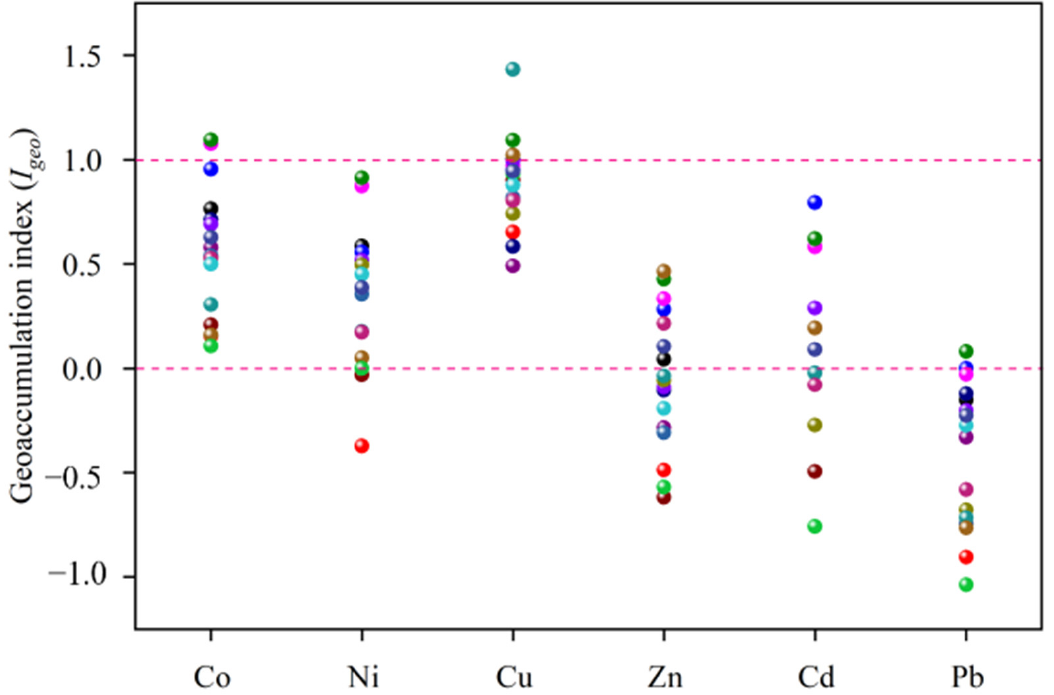
Figure 3. Geoaccumulation indexes for heavy metals in the sampling stations.